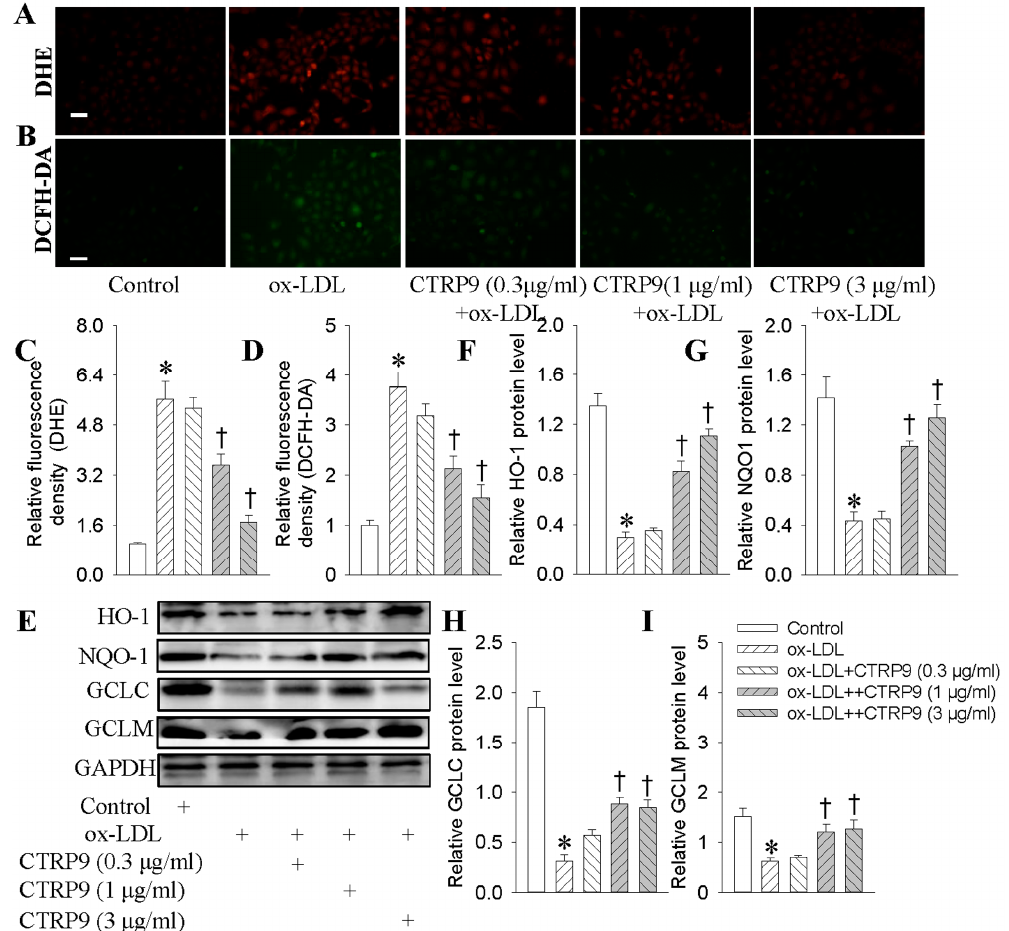
Figure 2. Effects of CTRP9 on the oxidative stress and antioxidant enzymes expressions in ox-LDL-treated HUVECs. HUVECs were pretreated with different doses of CTRP9 (0.3, 1 and 3 µ g/mL) for 6 h, and then were exposed to ox-LDL (100 µ g/mL) for 24 h; ( A , C ) The levels of superoxide anions detected by dihydroethidium (DHE) staining. Scale bar, 100 µ m; ( B , D ) The ROS levels measured by 2’,7’-dichlorofluorescein diacetate (DCFH-DA). Scale bar, 100 µ m; ( E , F ) The HO-1 (heme oxygenase-1) protein detected by Western blot; ( E , G ) The NQO-1 (NAD(P)H dehydrogenase quinone 1) protein detected by Western blot; ( E , H ) The GCLC (glutamate-cysteine ligase catalytic subunit) protein detected by Western blot. ( E , I ) The GCLM (glutamate-cysteine ligase modifier subunit) protein detected by Western blot. Values are mean ± SE. * p < 0.05 vs. Control, † p < 0.05 vs. ox-LDL. n = 4 for each group.